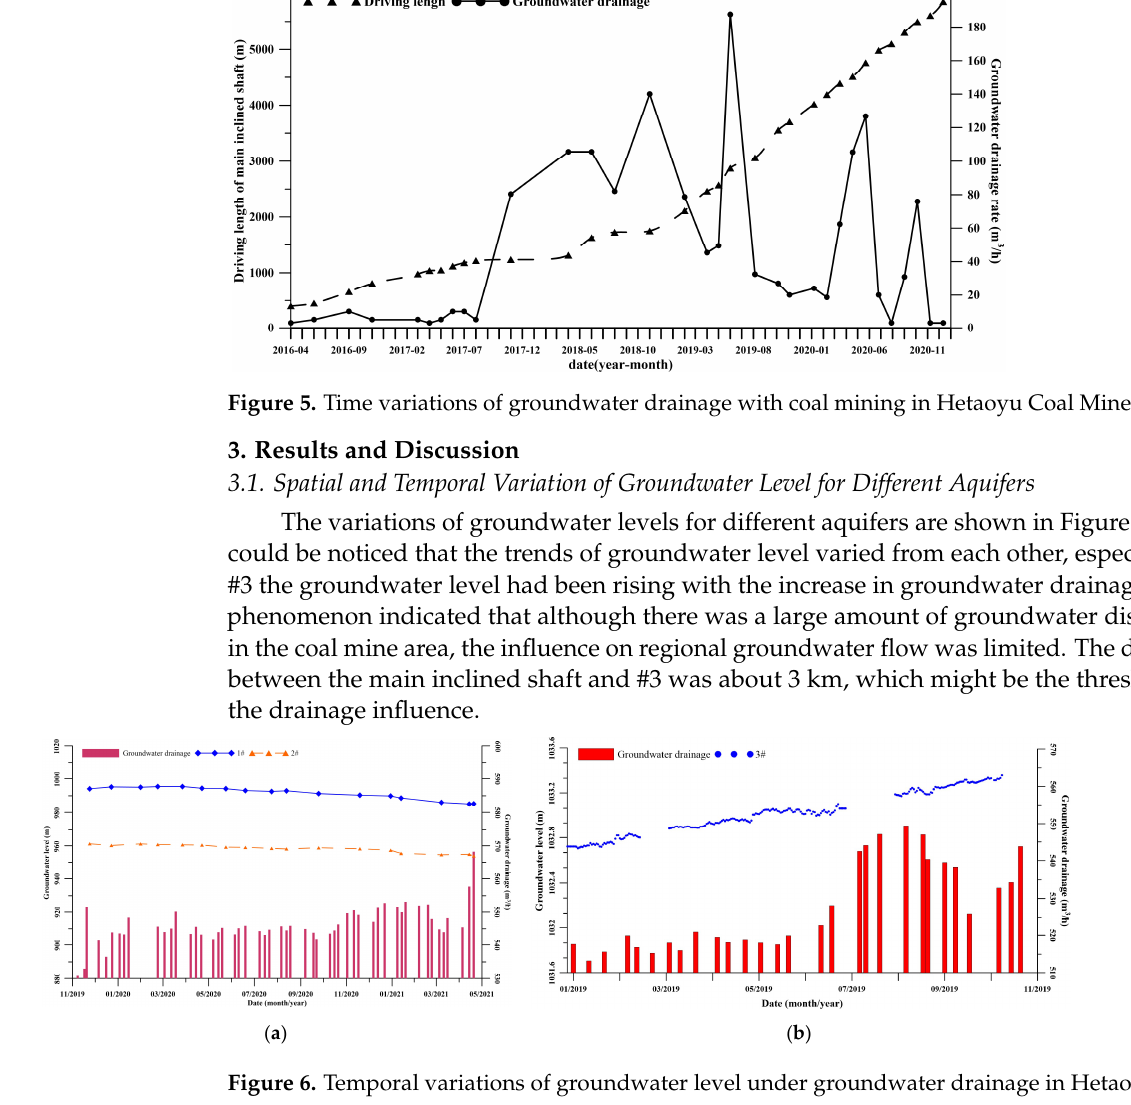
Mine. ( a ) Luohe aquifer (1#) and mixed groundwater level (2#). ( b ) Huanhe aquifer